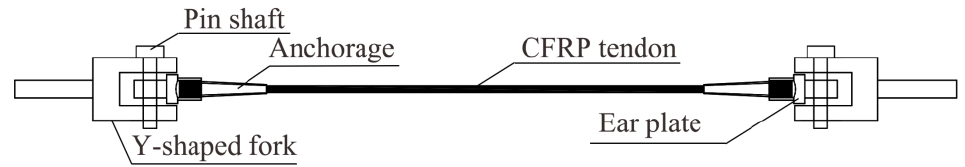
Figure 9. Assembly drawing of the CFRP strand tensile specimen.